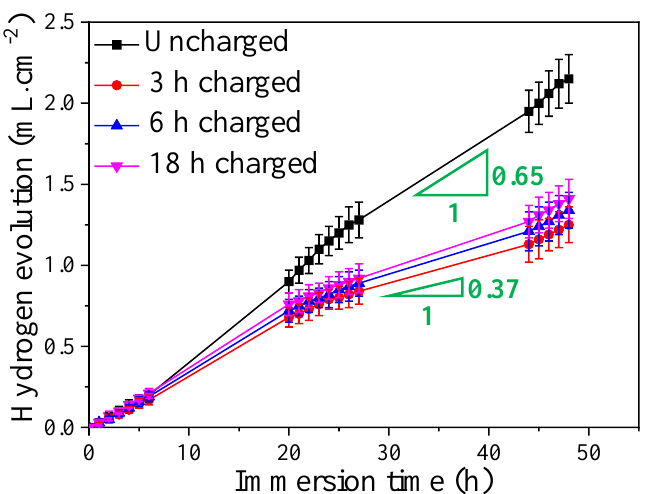
Figure 8. Hydrogen evolution curves of differently charged samples measured in a 0.1 M NaCl solution.